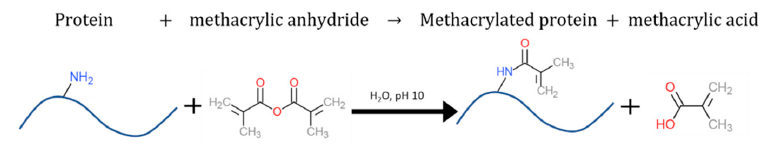
Figure 1. Methacrylation reaction of protein (adapted from Chan et al. [24]).